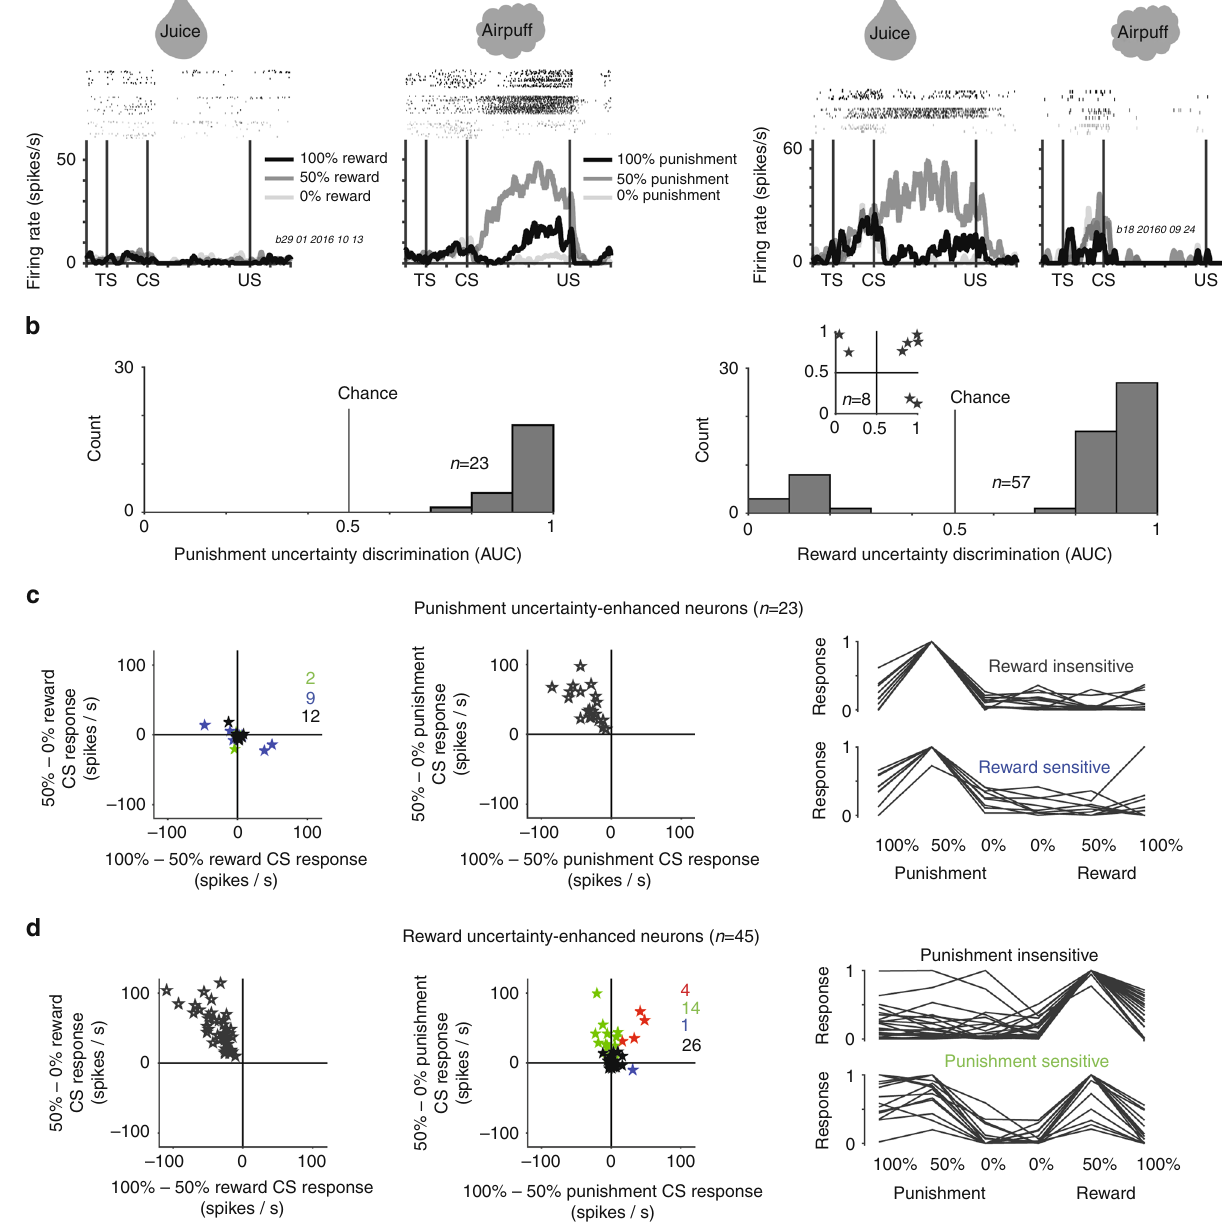
Fig. 5 Distinct coding of reward and punishment uncertainty by many ACC neurons. a Two single ACC neurons, one that signals punishment uncertainty ( left ) and one that signals reward uncertainty ( right ). b Single neuron discrimination indices of punishment and reward uncertainty-selective neurons ( left and right ). Inset shows discrimination of eight neurons that displayed uncertainty selectivity in both reward ( x -axis) and punishment blocks ( y -axis). Discrimination indices were obtained by ROC analyses (Methods). Values below 0.5 indicate selective suppression, indices above 0.5 indicate selective enhancement. c Punishment uncertainty-enhanced neurons in the reward block ( left-scatter plot ) and punishment block ( right-scatter plot ). Scatter plots show, for individual neurons, the differences between 50 vs. 100% CS responses ( x -axis) and 50 vs. 0% CS responses ( y -axis). Red stars , neurons showing signi fi cant differences in CS response in both 50 – 100% comparison and 50 – 0% comparison. Green stars , neurons showing signi fi cant differences in only 50 – 0% comparison. Blue stars , neurons showing signi fi cant differences in only 100 – 50% comparison. Black stars , neurons showing no signi fi cant differences. Single neuron and average CS responses ( right ) for two major groups of punishment uncertainty enhanced neurons ( black and blue stars on the left ). d Reward uncertainty-enhanced neurons. Conventions are the same as in Like all other populations of uncertainty or risk-coding were inhibited. Some reward uncertainty excited neurons also neurons, ACC uncertainty neurons discriminated between 100 carried information about punishment probability; Fig. 5d and and 0% CSs in their preferred block 37, 55 – 58 . Within the aversive Supplementary Fig. 7. Among these, almost all were enhanced by block, 9/23 punishment uncertainty neurons responded more to increased probability of punishment. Finally, a minority of 100 than 0% punishment CSs, and 3/23 responded more to 0 than uncertainty selective neurons (8/88) were selective for both 100%. 22/45 reward uncertainty enhanced neurons responded reward and punishment uncertainty (Fig. 5b).